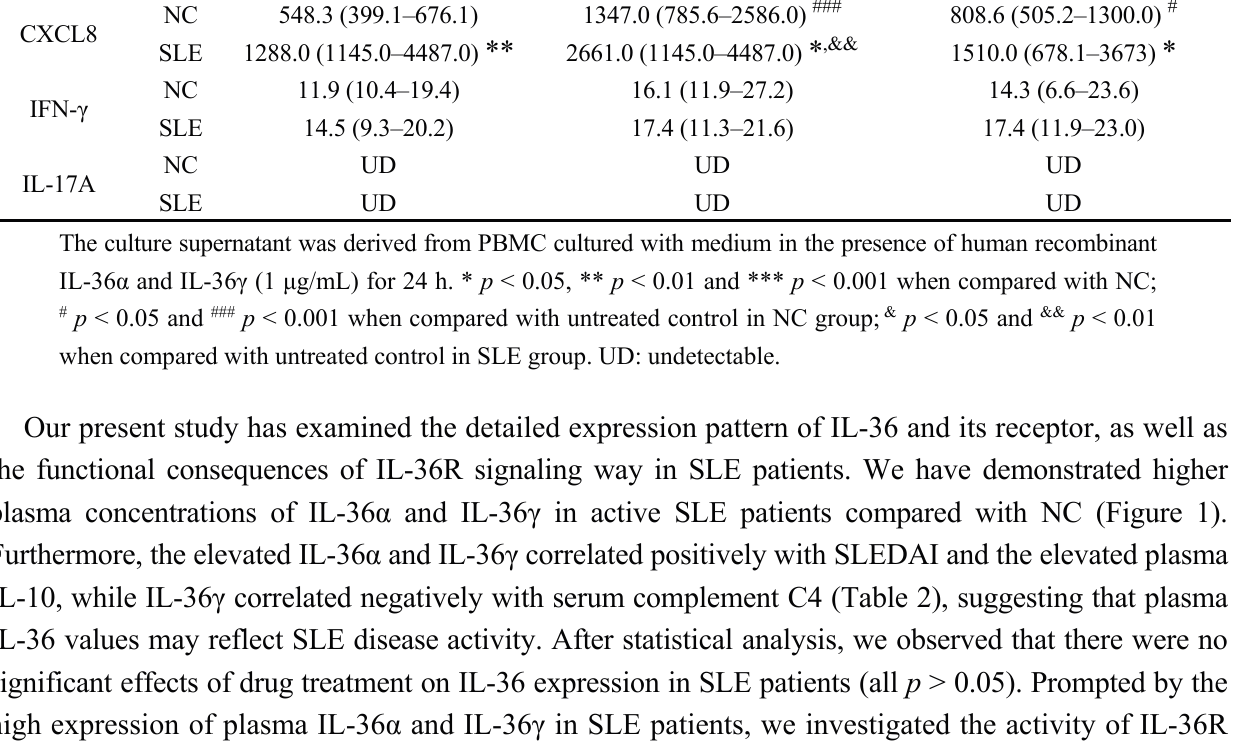
Table 3. Ex vivo induction of cytokine/chemokine from PBMC stimulated with IL-36. Cytokine/ Chemokine